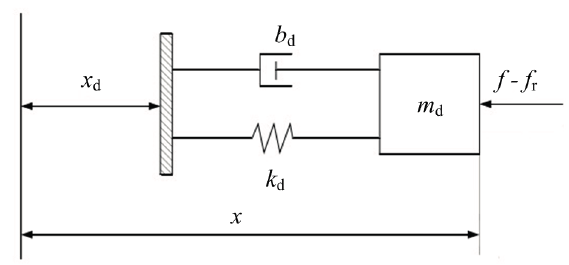
Figure 2. The flexible model of